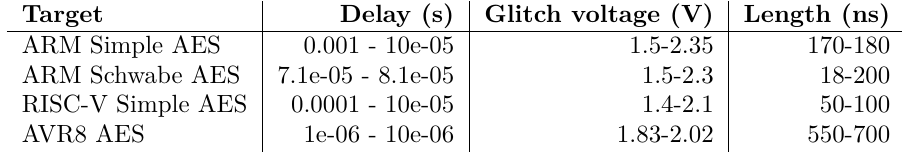
Table 4: FI parameter ranges used in our